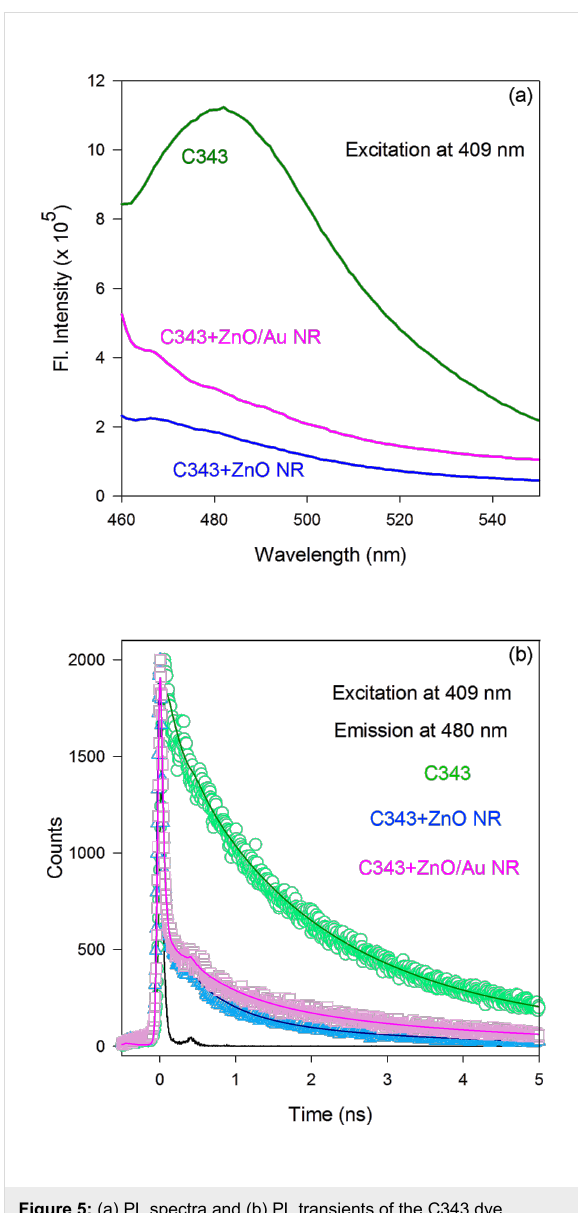
Table 4: J–V characteristics of bare ZnO-nanorod and ZnO/Au-nanocomposite DSSCs with different active areas, measured at 1 sun, AM 1.5 G illu- mination (100 mW/cm 2 ).